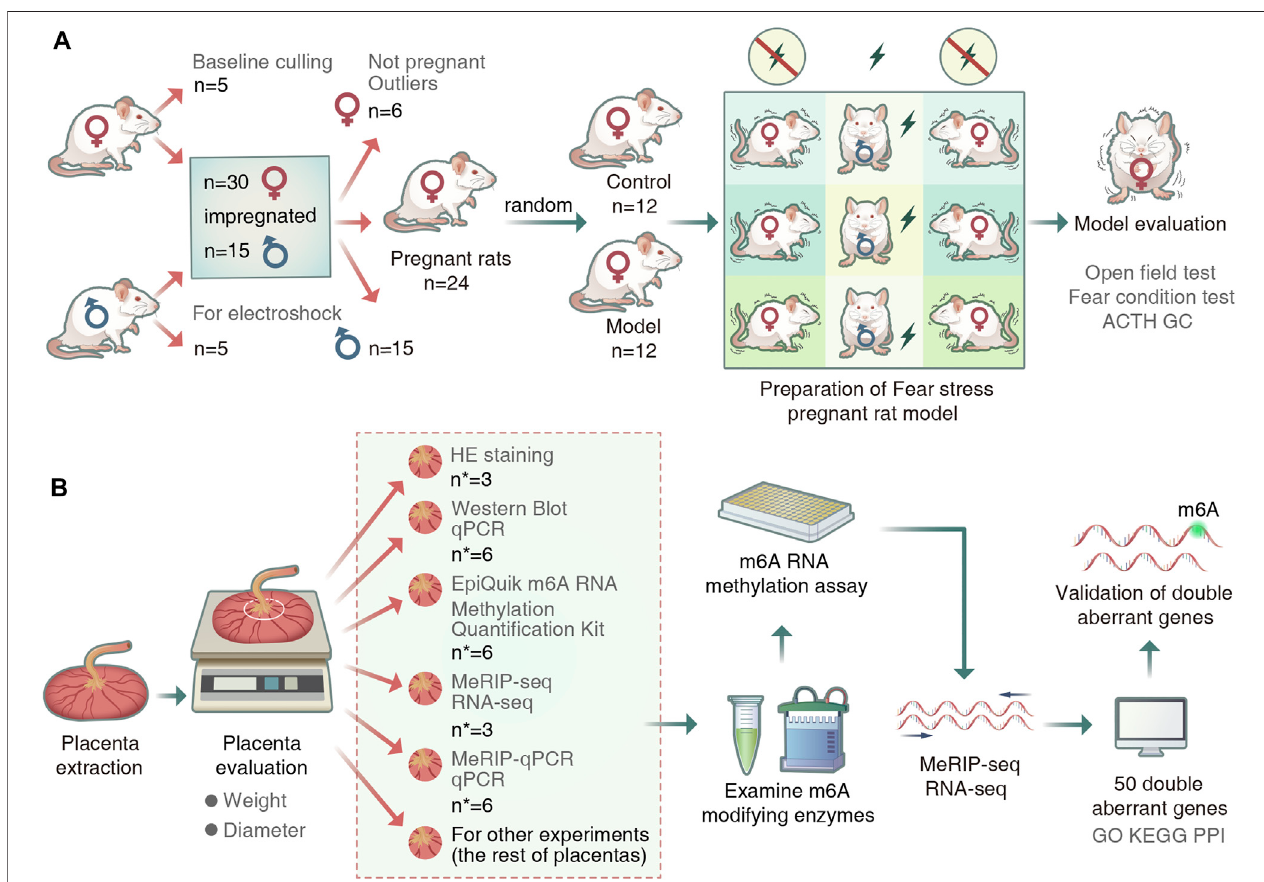
FIGURE 1 | Experimental procedure. (A) Animal grouping and model preparation. ( “ n ” represents the number of rats). (B) Schematic diagram of the experimental work fl ow. ( “ n p ” represented the number of placentas).